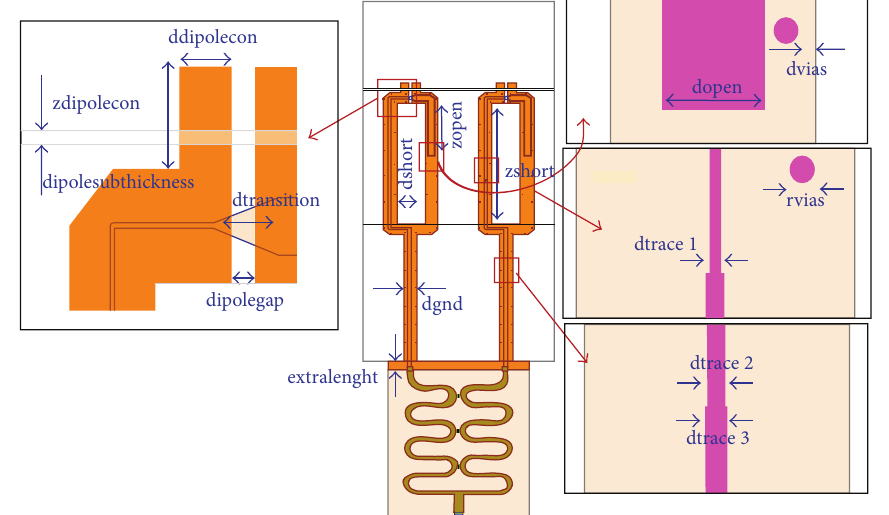
Figure 9: Parameter definitions for the TCDA-IB array are shown in Figure 5. This figure provides a listing of the various geometrical parameters that define the integrated balun. Values for the shown parameters are given in Table 1.